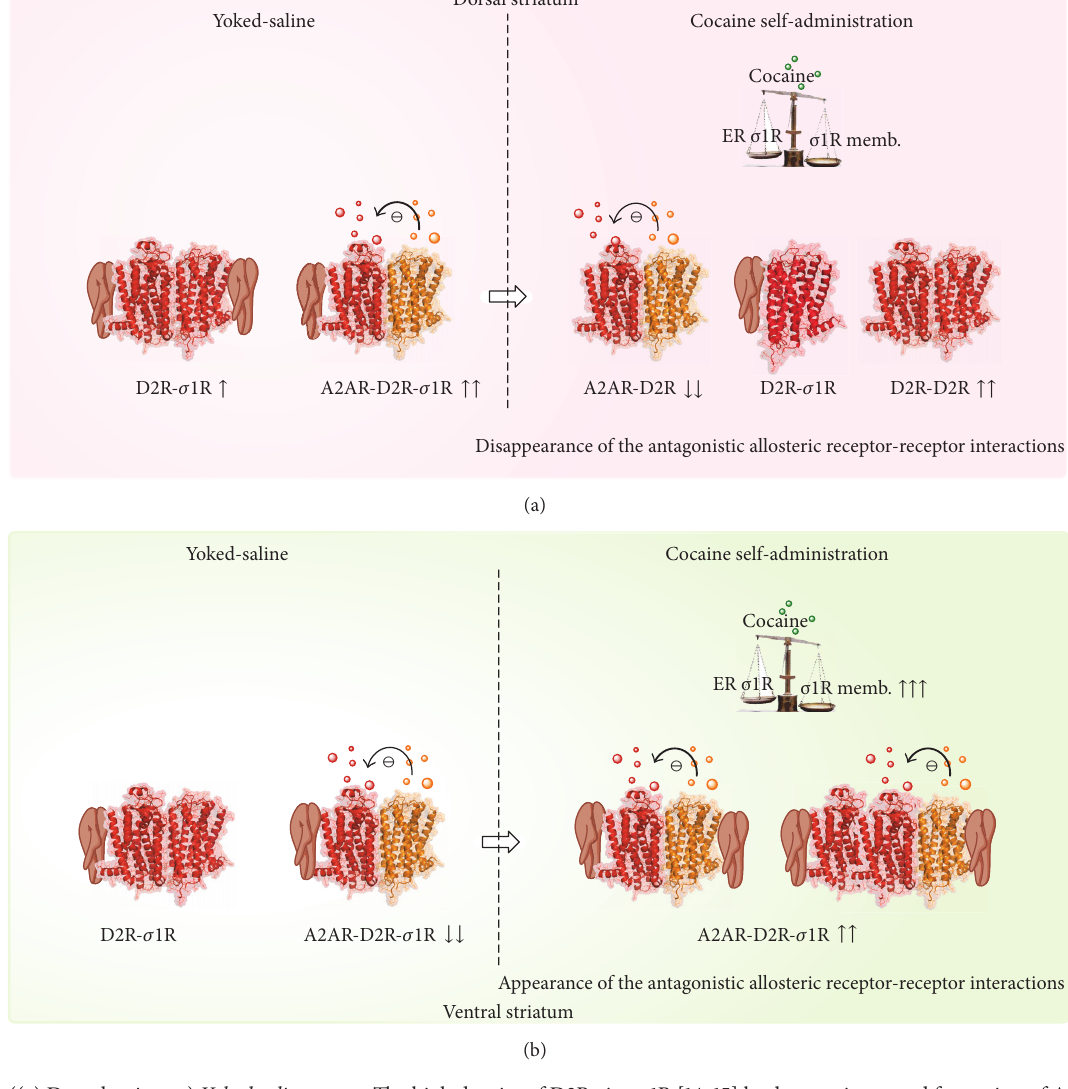
Figure 2: ((a) Dorsal striatum) Yoked saline group . The high density of D2R-sigma1R [14, 15] leads to an increased formation of A2AR-D2R- sigma1R heterocomplexes which together with the A2AR-D2R heterocomplexes can be in dominance over D2 homoreceptor complexes. This can help explain the significant antagonistic A2AR-D2R interaction observed [16]. Cocaine self-administration (maintenance) group . Cocaine can bind to the sigma1R [17] but does not increase its recruitment to the plasma membrane in the dorsal striatum [18]. Instead, it is proposed that the major change induced by cocaine can be the increase in extracellular DA levels which is postulated to increase the formation of D2R homoreceptor complexes. Duetocompetition, thiscan reducethenumberofA2AR-D2Rand A2AR-D2R-sigma1Rheteroreceptor complexes. As a result, the antagonistic allosteric A2AR-D2R interactions disappear [16]. ((b) Ventral striatum) Yoked saline group. The lower density of D2R-sigma-1R, especially in nuc accumbens core [14, 15], may lead to the preferential formation of D2R-sigma1R heterocomplexes in view of a possible higher affinity of sigma1R for D2R monomer-homoreceptor complexes versus the affinity for the A2AR-D2R heteroreceptor complexes. Due to competition, the A2AR-D2R heteroreceptor complexes will become reduced and only weak nonsignificant antagonistic A2AR-D2R interactions develop. Cocaine self-administration (maintenance) group . Upon cocaine self-administration, cocaine can here increase sigma1R expression [18] and increase its recruitment to the plasma membrane where it interacts with D2R potentially at several interfaces. In view of the marked increase of sigma1R in the plasma membrane increased formation of A2AR-D2R-sigma1R heteroreceptor complexes can develop with restoration of significant antagonistic A2AR-D2R interactions [16] in spite of increases in extracellular DA levels postulated to favour D2R